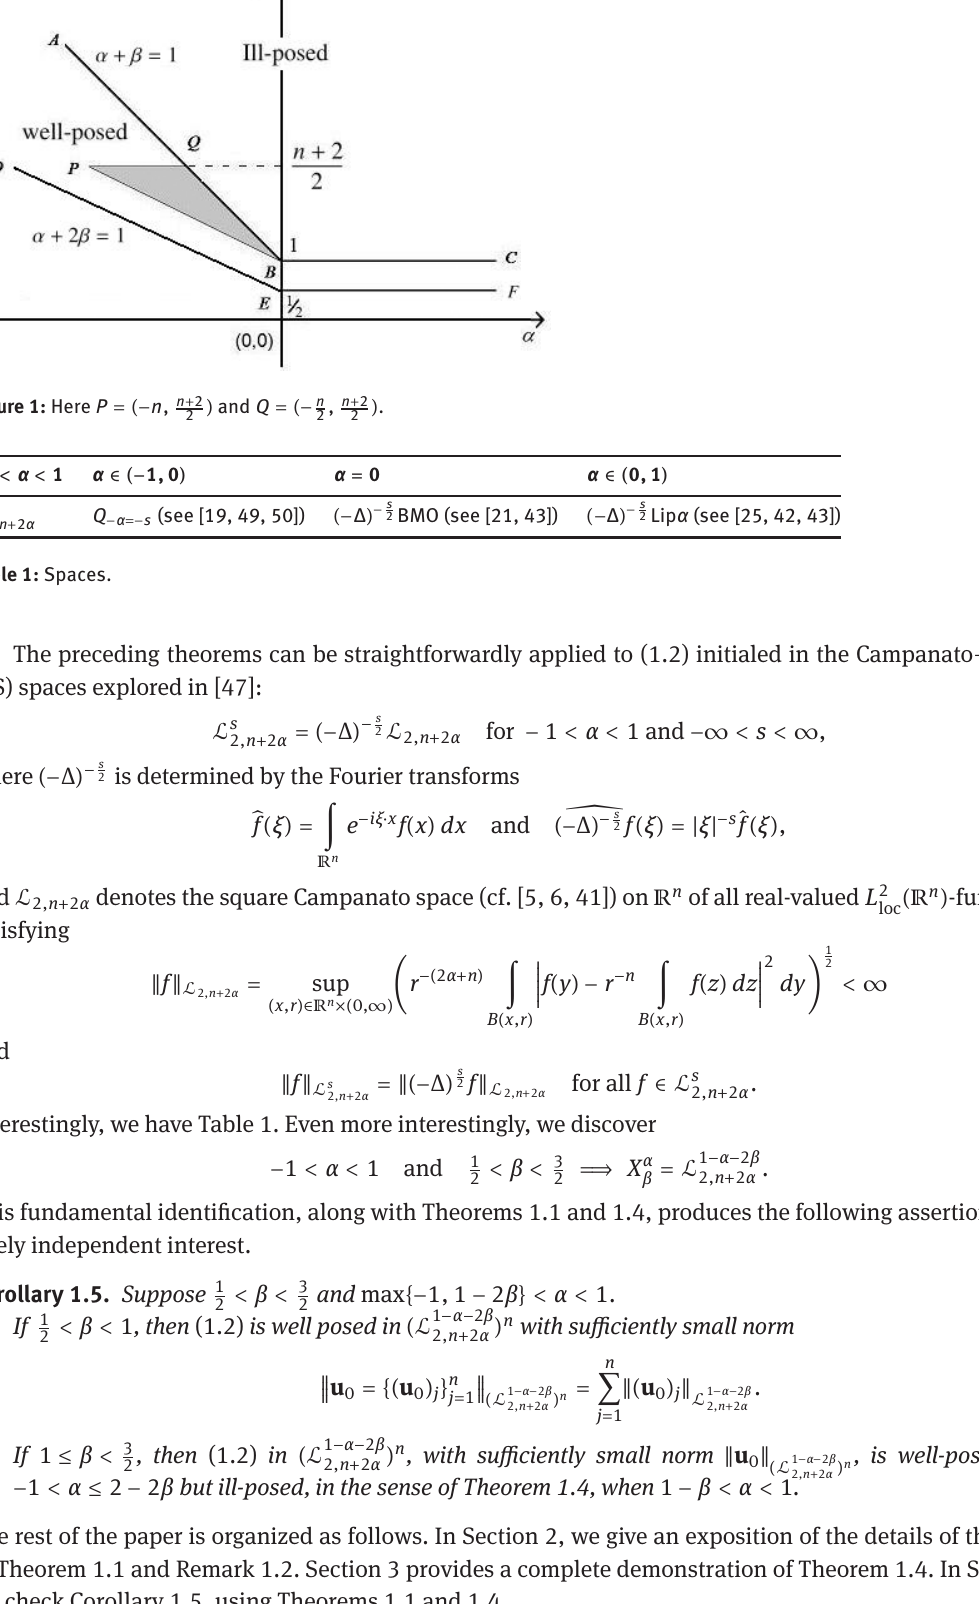
Figure 1: Here P = (− n , n + 2